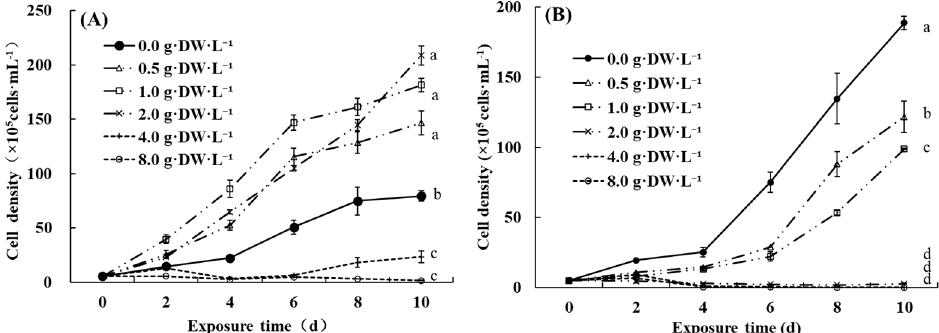
Figure 1. The cell density changes of C. vulgaris ( A ) and M. aeruginosa ( B ) exposed to varying concentrations of aqueous extracts of D. indicum flowers (g·DW·L − 1 ) in mono-culture bioassays. Different letters indicate significant differences among varying groups at p < 0.05 level.